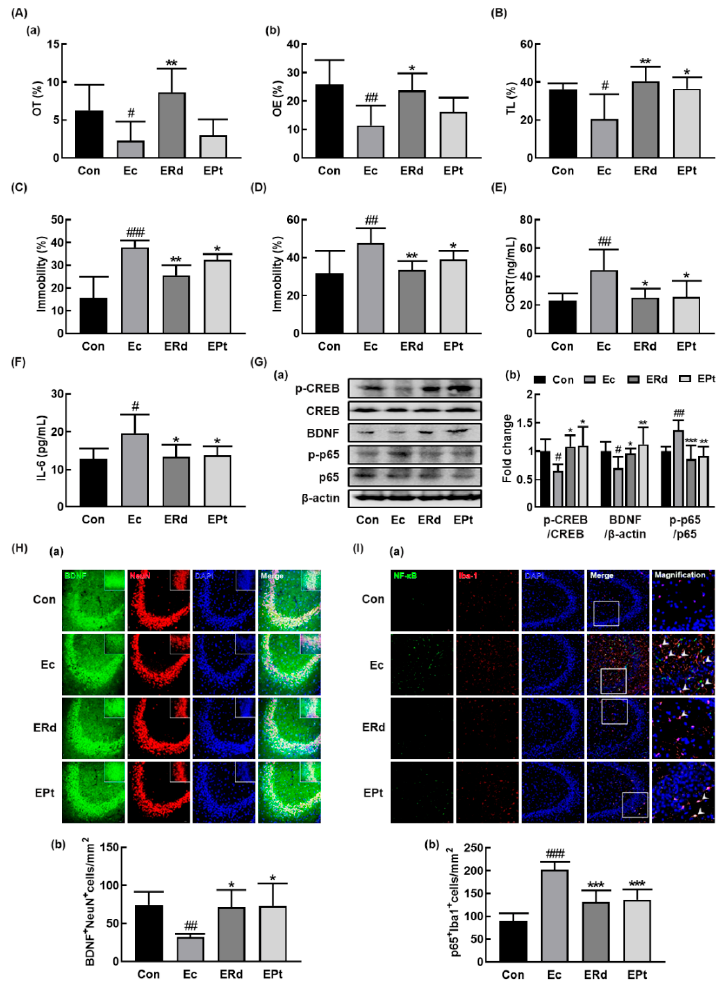
Figure 4. Oral administration of ginsenoside Rd and protopanaxatriol alleviated Escherichia coli K1 (EC)-induced anxiety/depression and colitis in mice. Effects on anxiety/depression-like behaviors in elevated plus maze ( A : ( a ), OT; ( b ), OE), light/dark transition test ( B ), forced swimming test ( C ), and tail suspension test ( D ). Effects on corticosterone (CORT, E ) and IL-6 levels ( F ) in the blood. ( G ) Effects on BDNF expression, CREB phosphorylation, and NF- κ B activation in the hippocampus. Effects on the infiltration of BDNF + /NeuN + ( H ) and NF- κ B + /Iba1 + cells ( I ) into the CA3 region of hippocampus. Mice were exposed to EC (1×10 9 CFU/mouse/day) and test agents (Ec, vehicle [saline]; ERd, 5 mg/kg/day of ginsenoside Rd; EPt, 5 mg/kg/day of protopanaxatriol) were gavaged daily for 5 days. Normal control group (Con), not exposed to EC, was treated with saline instead of test agents. p65, p-p65, CREB, p-CREB, and β -actin were analyzed by immunoblotting. Blood IL-6 and corticosterone levels were assayed by ELISA kits. Data values were indicated as mean ± SD ( n = 6)). # p < 0.05 vs. Con group. ## p < 0.01 vs. Con group. ### p < 0.001 vs. Con group. * p < 0.05 vs. Ec group. ** p < 0.01 vs. Ec